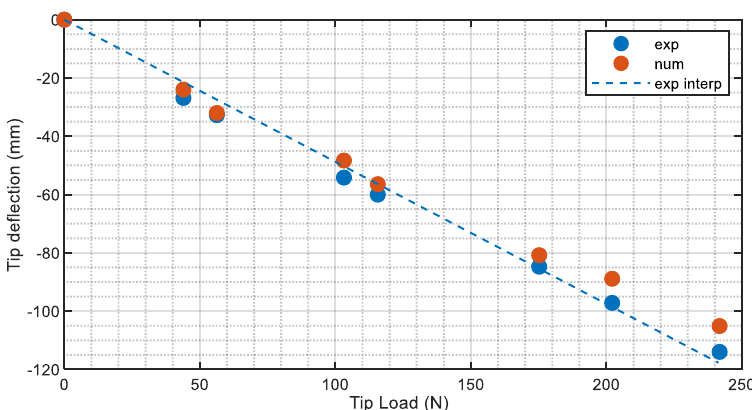
Figure 17. FEA (Finite Element Analysis) and experimental tip deflection.